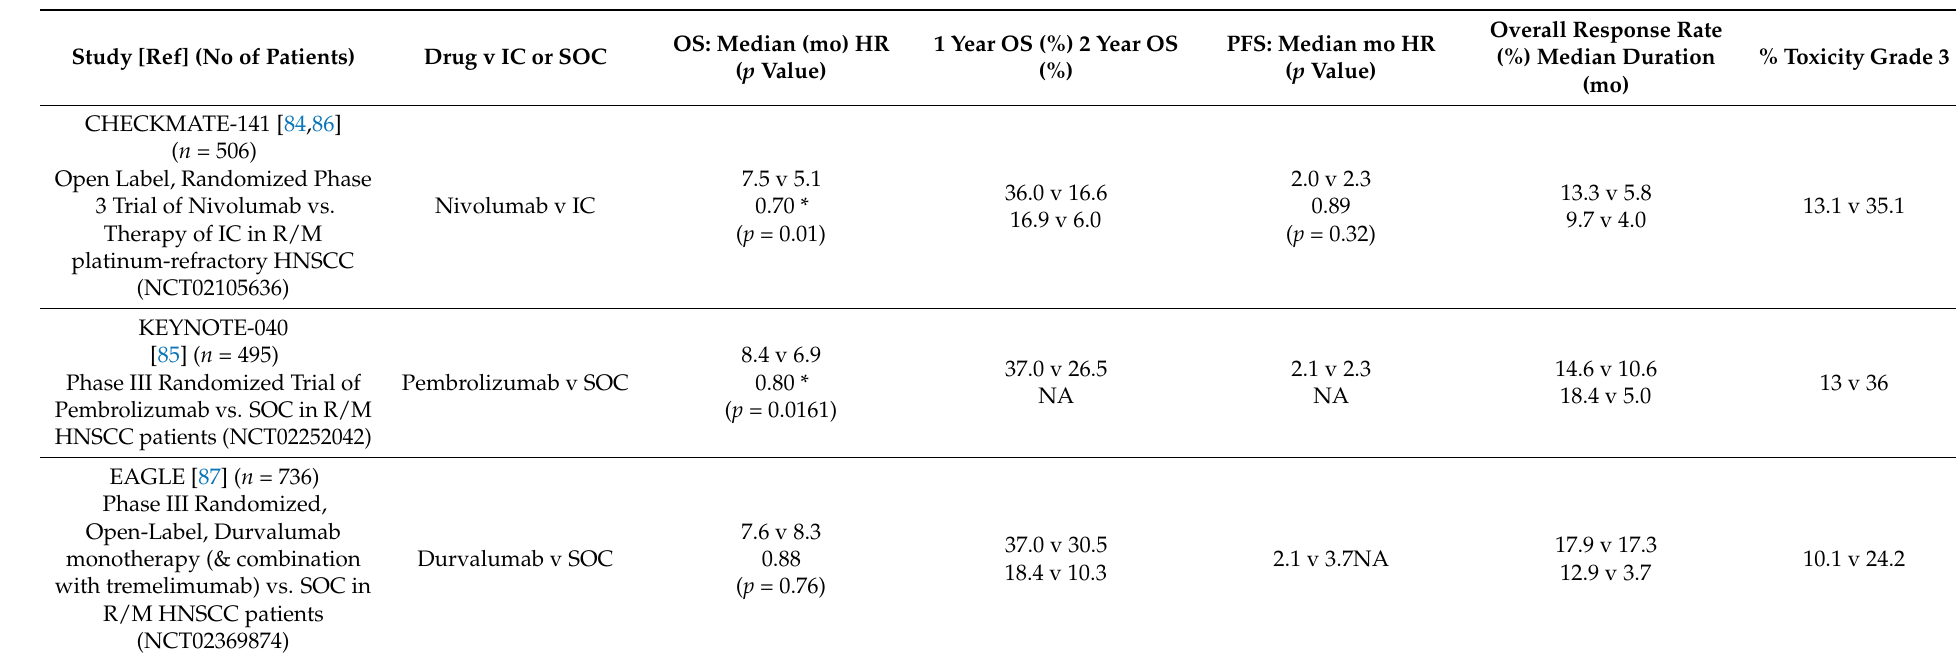
Table 2. Key immune checkpoint inhibitor clinical efficacy trials for